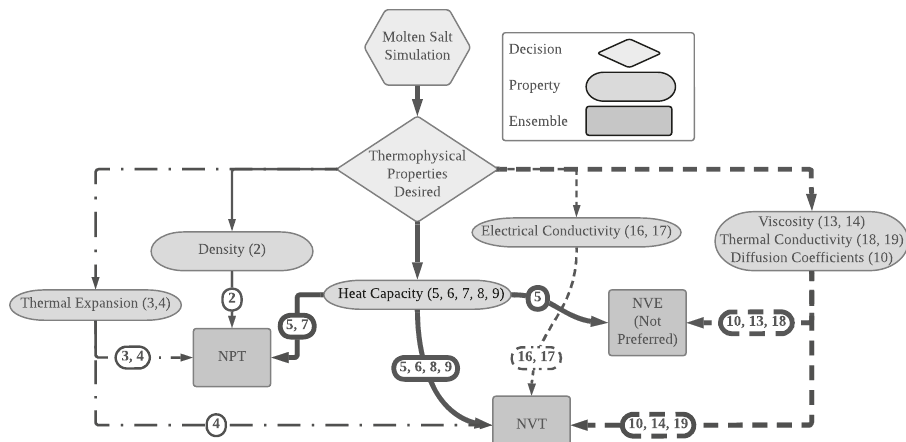
Fig. 3 Simulation strategies for molten salts to obtain thermophysical properties. Each property is followed by the equation number listed in the text that can be used to derive the property from the simulation data. The arrows connecting the properties with the simulation ensemble (NPT, NVE, and NVT) are again marked with the equation numbers. For example, thermal expansion can be calculated from NVE simulation with Eq. 3 or from NPT simulation with Eq. 2, however, the NPT simulation is the preferred route. Reverse non-equilibrium molecular dynamics (RNEMD) and equilibrium molecular dynamic (EMD) are explained further in the